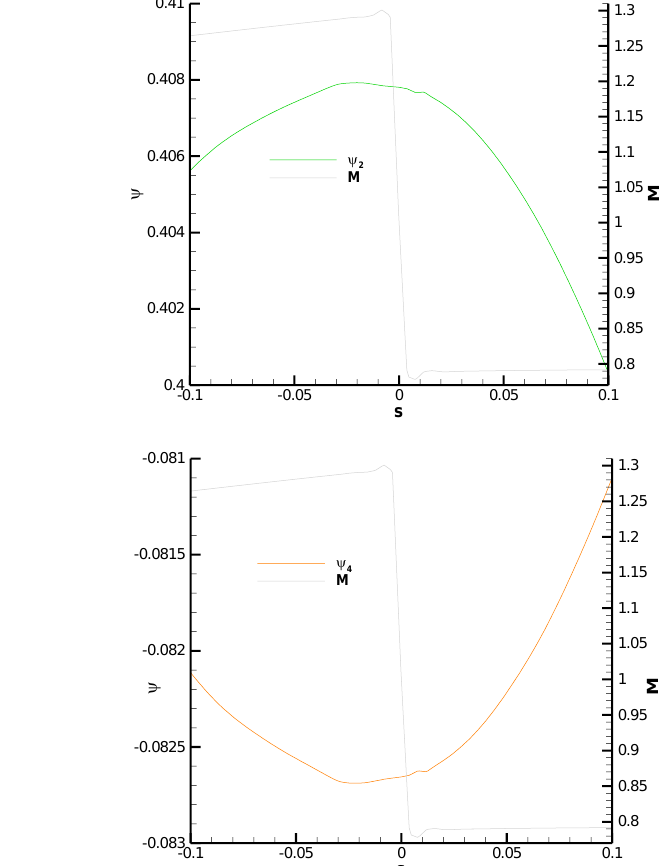
Figure 17. Flow past a NACA0012 airfoil at M = 0.8 and α = 5.794°. Adjoint normal derivatives across the shock. 5. Conclusions In 2D, the adjoint variables of typical cost functions are continuous at shocks and obey a differential equation along the length of the shock. In this work, we have focused